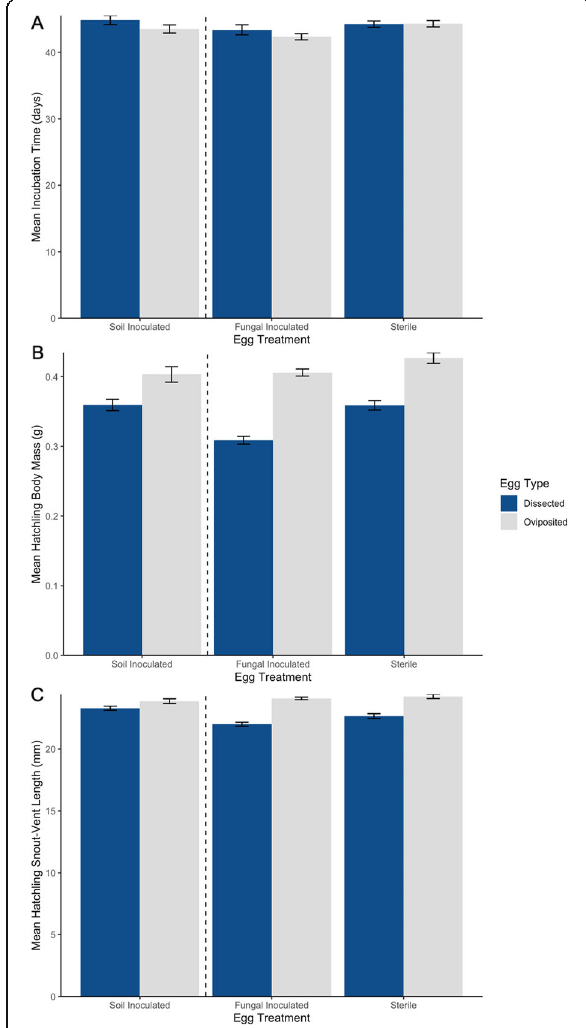
Fig. 8 Mean (± SE) A incubation time, B body mass, and C SVL of hatchlings that emerged from dissected and oviposited S. virgatus eggs. In 2017, eggs were incubated in vermiculite inoculated with a soil slurry from the native range of S. virgatus . In 2019, eggs were incubated in vermiculite inoculated either with a fungal suspension derived from fungus that had infected failed S. virgatus eggs, or with sterile water. The dashed lined separates results from 2017 and 2019. Hatchlings from dissected and oviposited eggs did not differ in incubation size, but did significantly differ in mass and